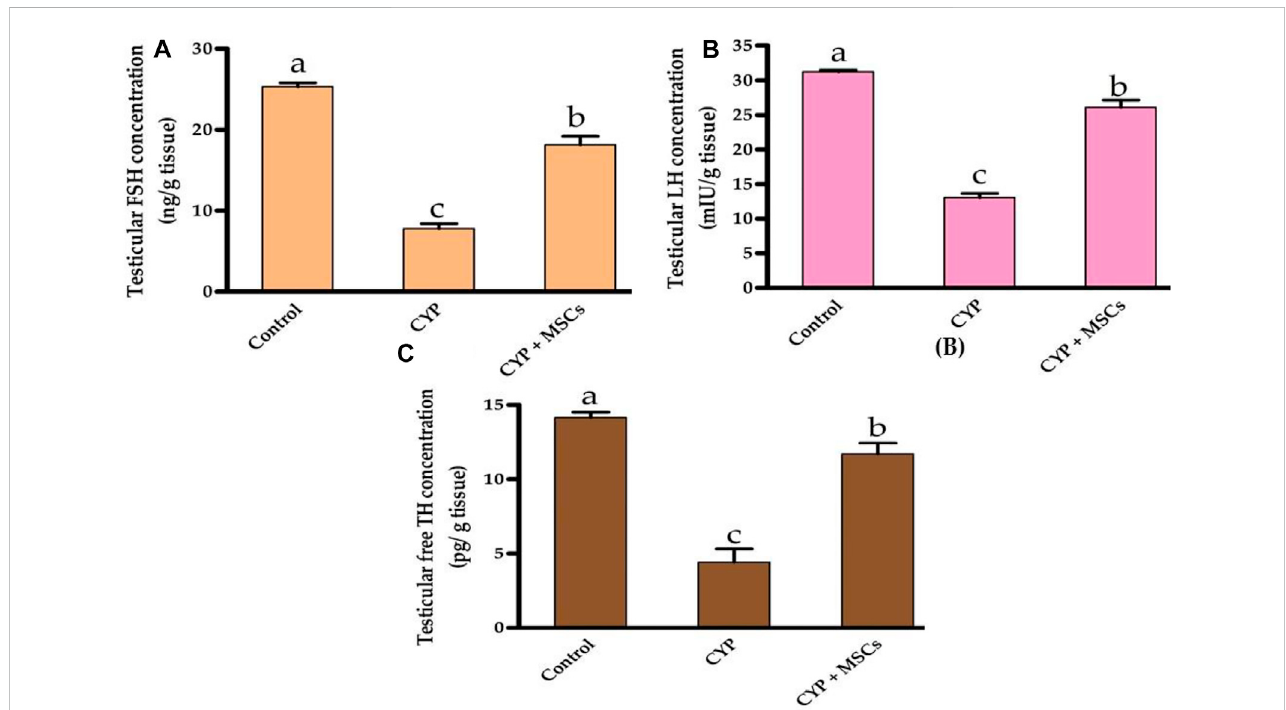
FIGURE 2 In fl uences of CYP with/without MSCs transplantation on testicular hormones concentrations; (A) testicular FSH, (B) testicular LH, and (C) testicular free TH. Data described as mean ± SD (n = 6). DMRTs show that bars with various letters are substantially different at p = 0.05.